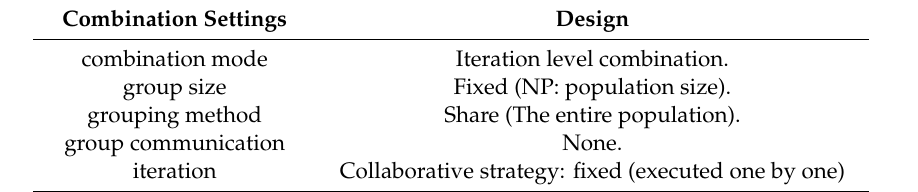
Table 4. Behavior Combination